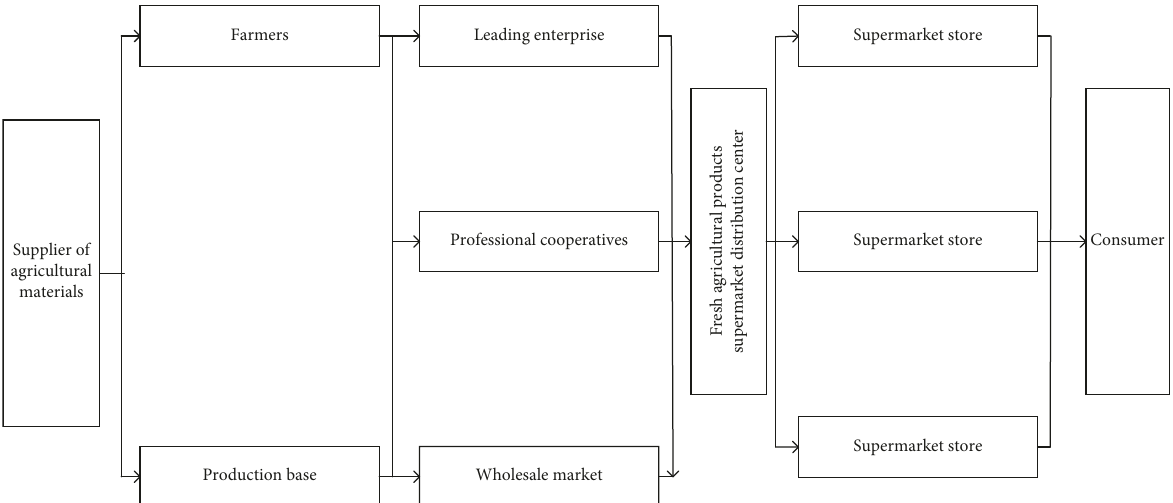
Figure 10: “Agricultural superdocking” mode